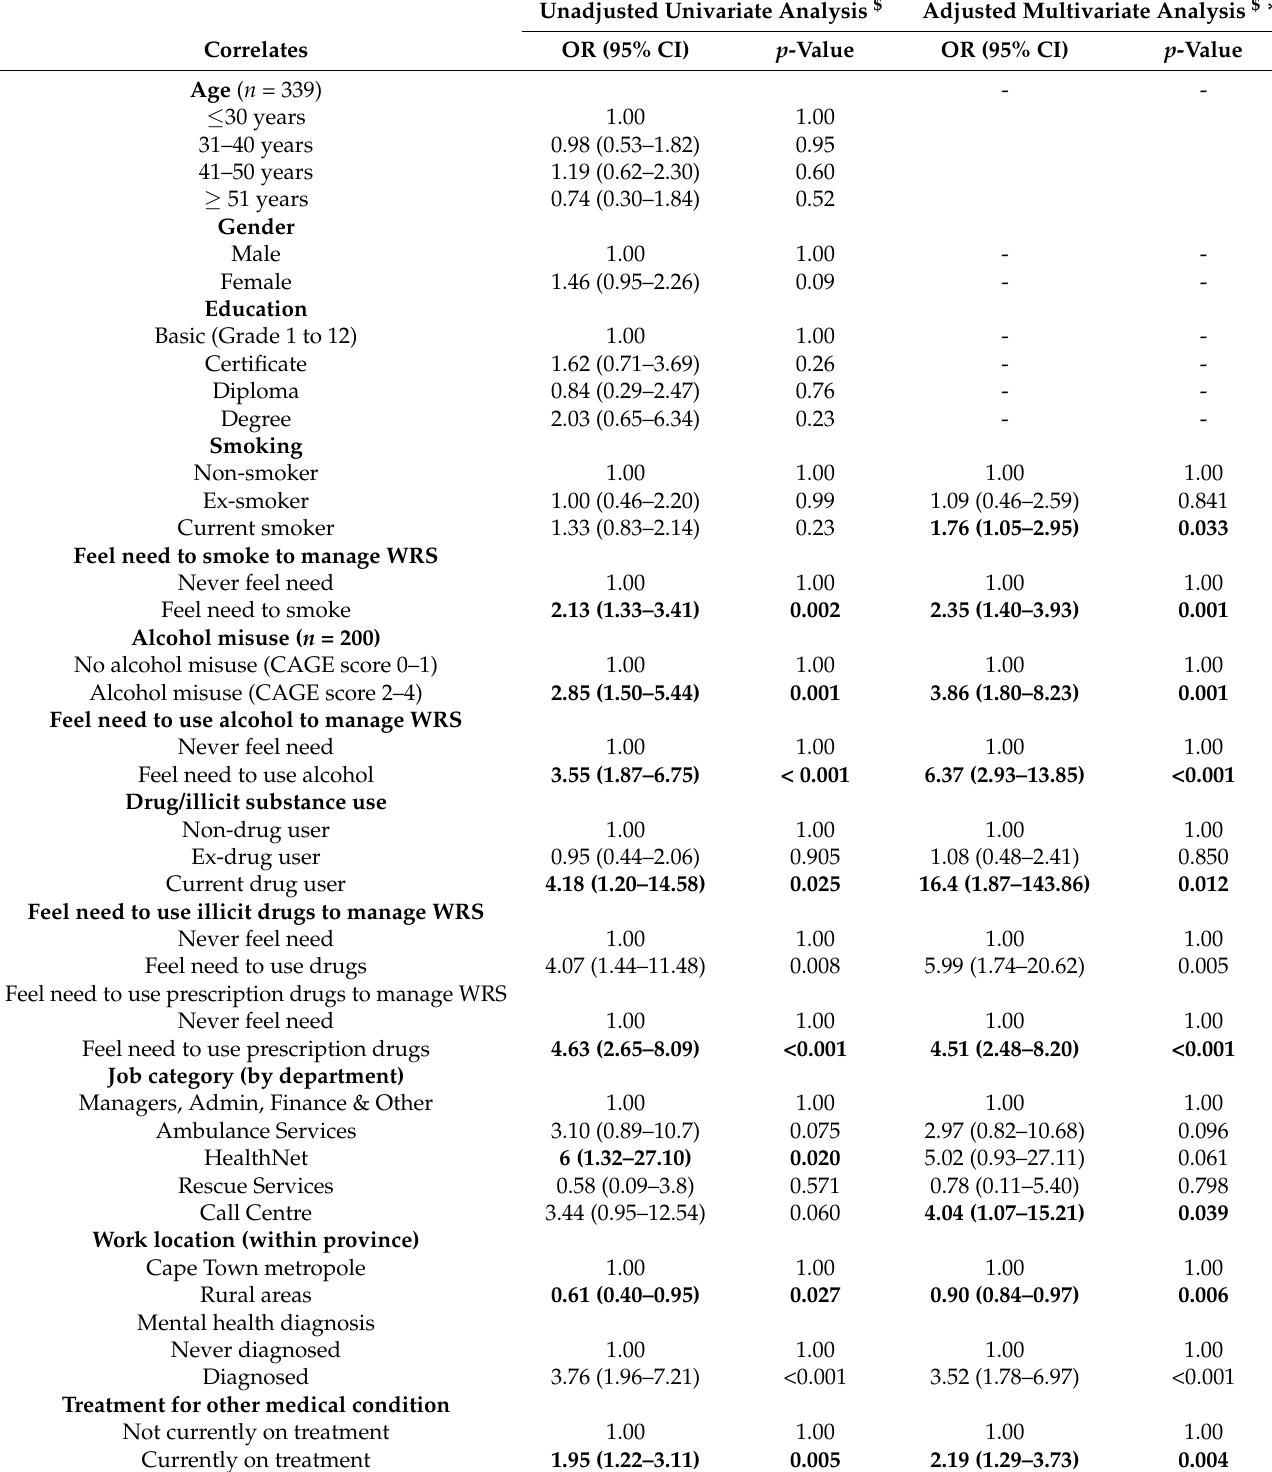
Table 6. Unadjusted and adjusted regression analysis of the correlates of PTSD (N = 388). Unadjusted Univariate Analysis $ Adjusted Multivariate Analysis $